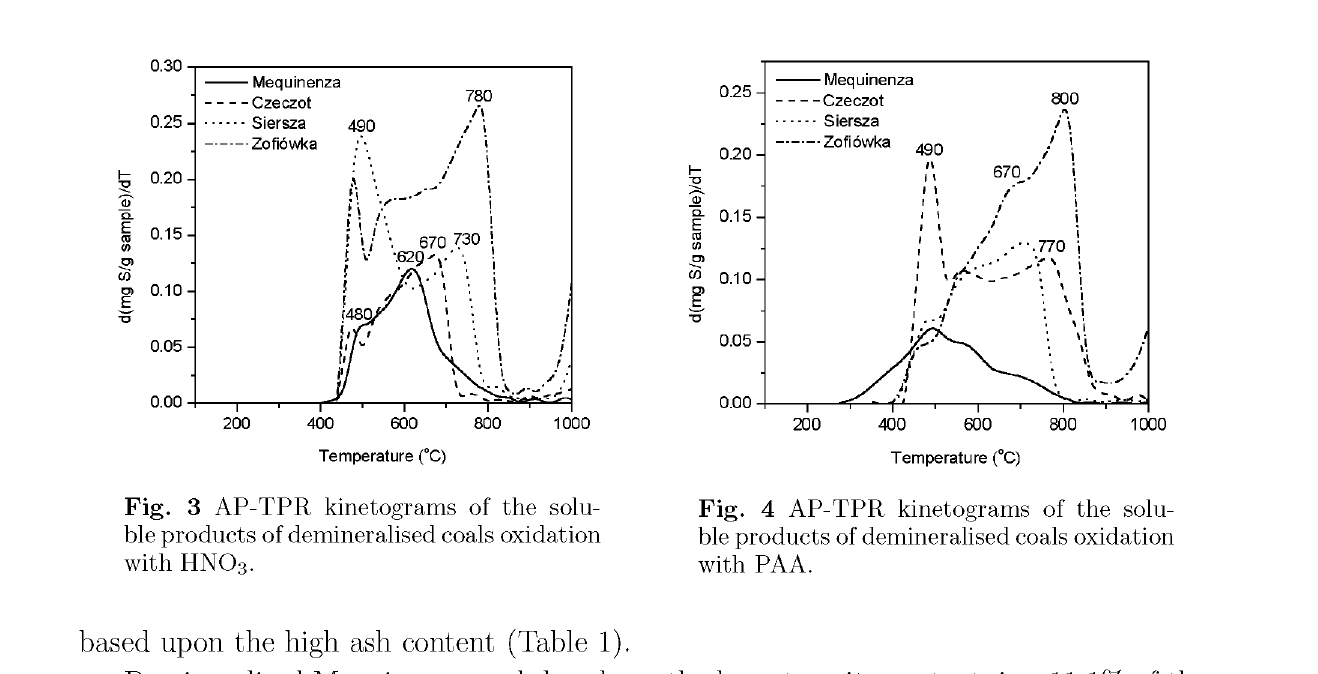
Fig. 4 AP-TPR kinetograms of the solu- ble products of demineralised coals oxidation with PAA.